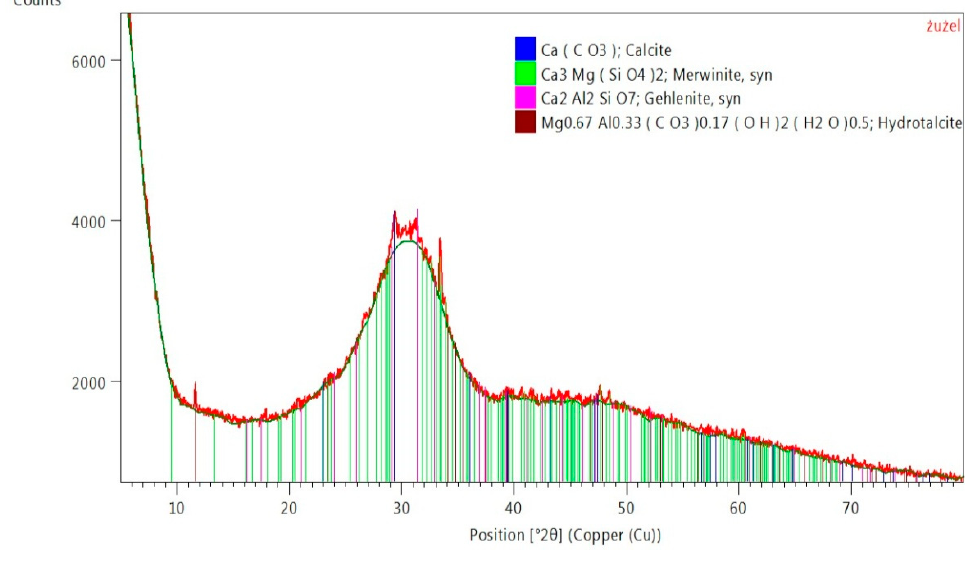
Figure 3. Phase composition of GGBFS [71].